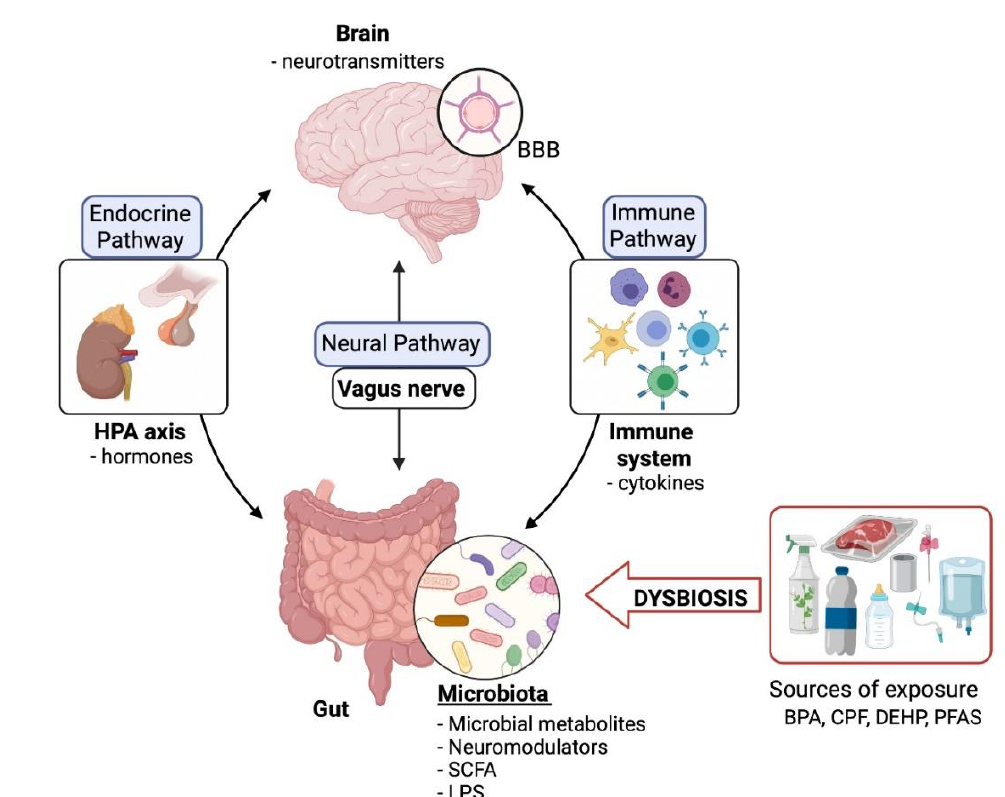
Figure 5. Impact of contaminants on the microbiota–gut–brain axis and linkage with neurotoxicity.